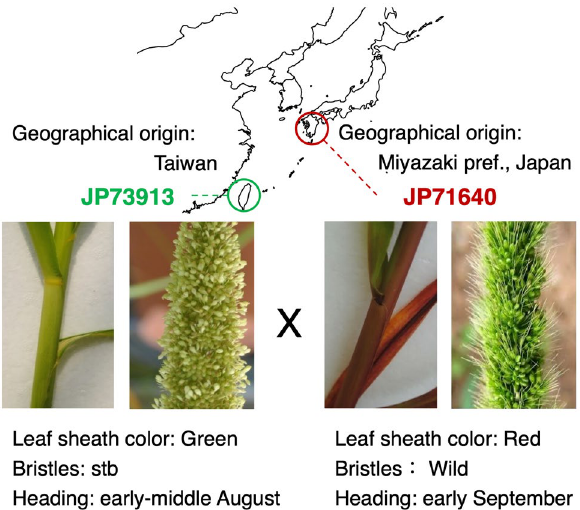
Figure 1. Characteristics of parental landraces. Maternal parent: JP73913 from Taiwan with green leaf sheath and spikelet-tipped bristles (stb) and heading early-middle August. Pollen donor: JP71640 from Miyazaki Prefecture, Japan, with red leaf sheath and wild type of bristles and heading early September. The map was created using the R package “maps” ver. 3.3.0 (https:// CRAN.R- proje ct. org/ packa ge=